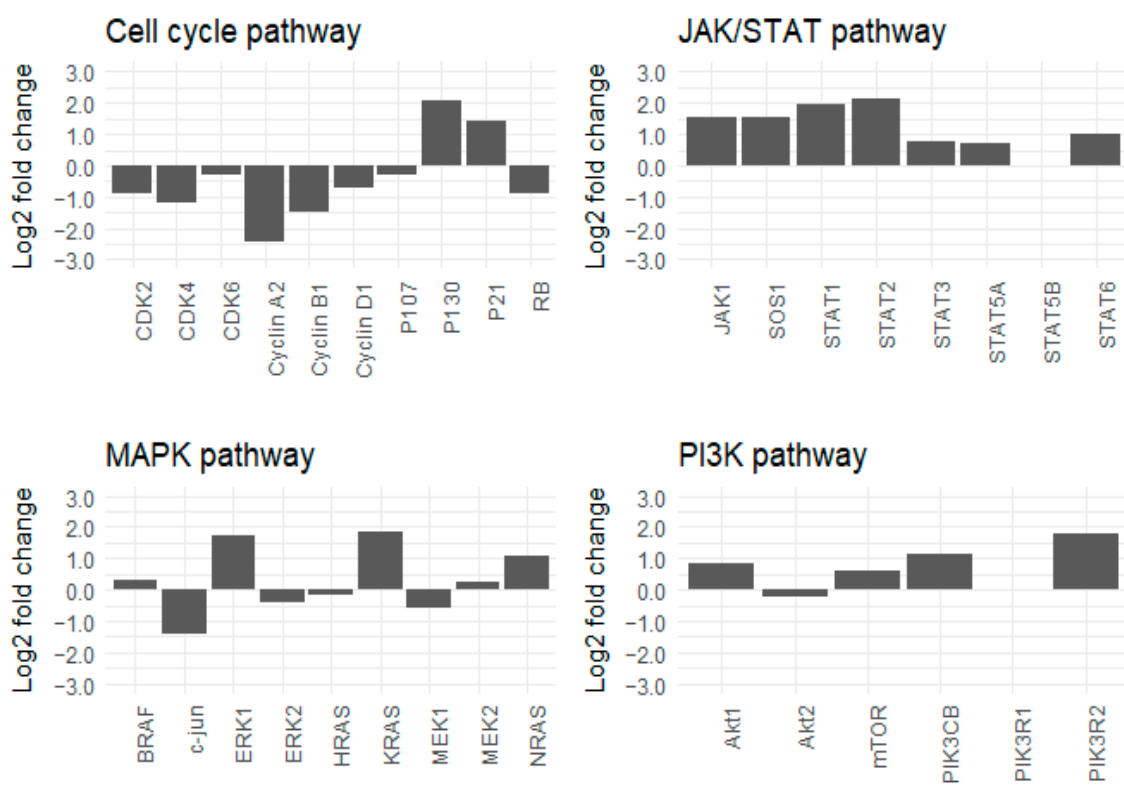
Figure 3. CAL27 cell line: Log2-fold change in values determined by proteomic analyses for proteins identified as important regulators of the cell cycle, JAK/STAT, PI3K/Akt and MAPK pathways.